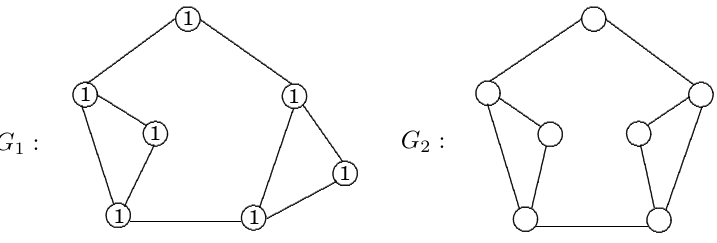
Figure 1: A zonal plane graph and a non-zonal plane